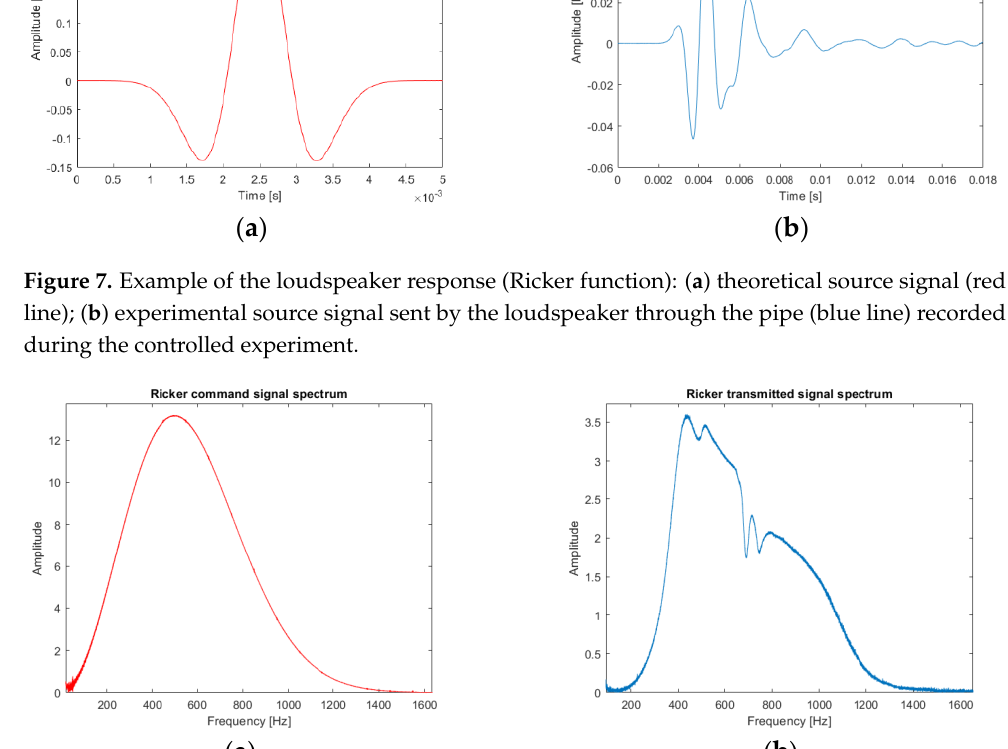
Figure 8. Fourier transform of the Ricker function: ( a ) theoretical Ricker spectrum (red line) showing the central frequency of the theoretical source around 500 Hz; ( b ) experimental Ricker spectrum (loudspeaker output; blue line) showing a central frequency around 500 Hz but distorted in relation to the command.